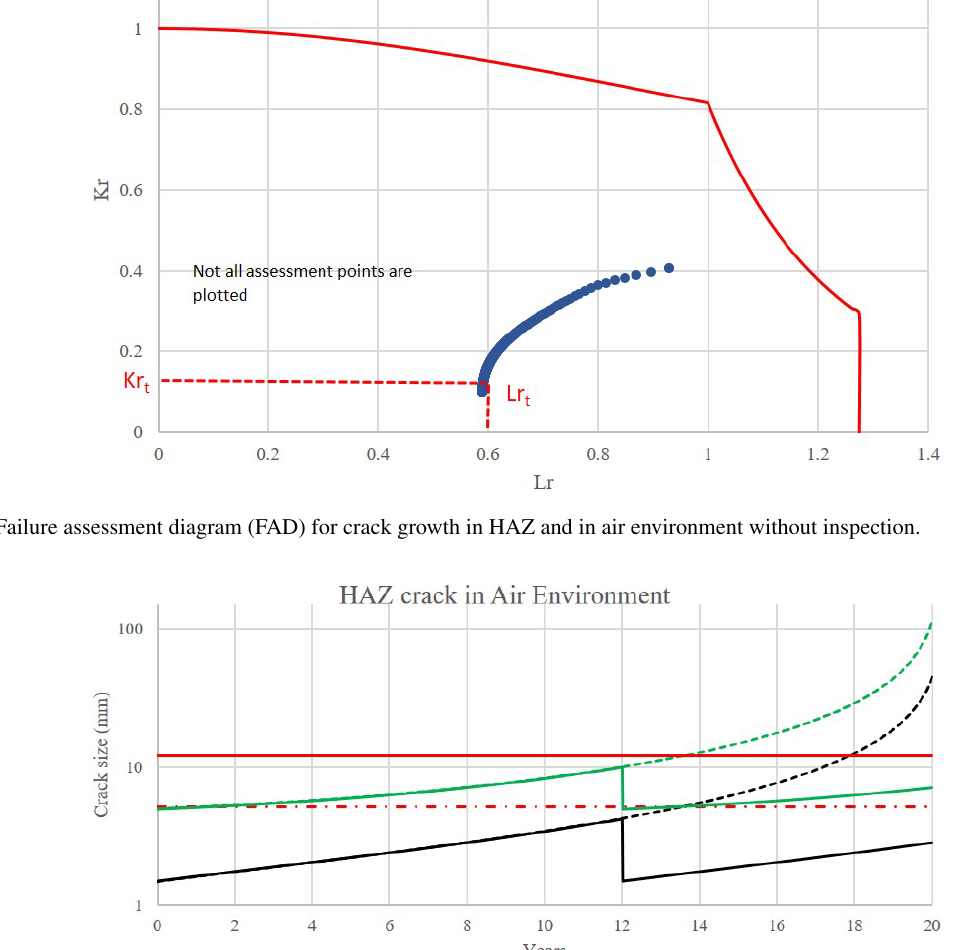
lines after year 12 in Fig. 21. The final-year crack size re- mains below the tolerable